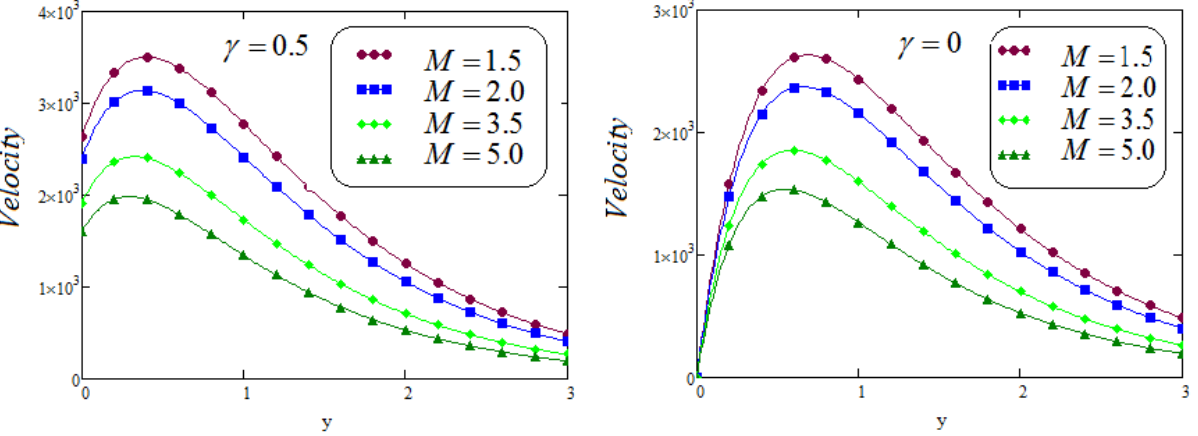
Figure 5. Velocity field under slip conditions as well as the velocity field under no-slip conditions for different M values when f ( t ) = e at , a = 0.25, t = 1.5, Gr = 3.5, λ 1 = 0.6, λ 2 = 0.2, Pr =